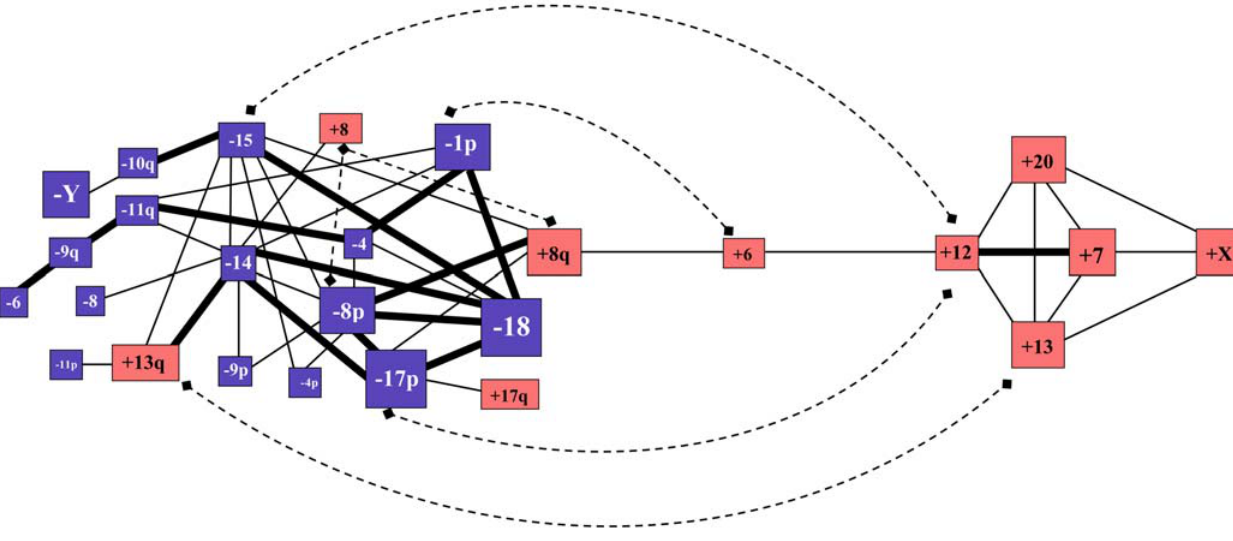
Figure 3. The two major chromosomal pathways in near-diploid CRCs. Schematic representation of the two-by-two association study presented in Supplementary Table S4. Positive (continuous lines) and negative (dotted lines) associations are represented by thick and thin lines indicating significant associations at p=0.01 and 0.05 level, respectively. The size of each box is proportional to the frequency of the alteration, whole-chromosome or chromosome arm gains (red background), and chromosome losses or deletions (blue background) being distinguished. The preferential associations between alterations involving both arms of the same chromosome, such as -8p and + 8q, or -17p and + 17q, need to be interpreted with caution since they originate mostly from a single isochromosome formation event. For instance, gain of 17q seems to be a side effect of 17p deletion via isochromosome 17q formation (10/11 tumors with 17q gain also exhibited 17p loss whereas 17p loss alone was observed in an additional 30 tumors) whereas both 8p loss and 8q gain might provide tumor cells with a selective advantage since although associated in 20 tumors, these alterations were also observed independently in 8 and 7 tumors, respectively (see also Supplementary Figure S1). Some negative associations (between + 13 and + 13q, + 8 and + 8q, + 8 and -8p) could also be due to the fact they involve the same chromosome.